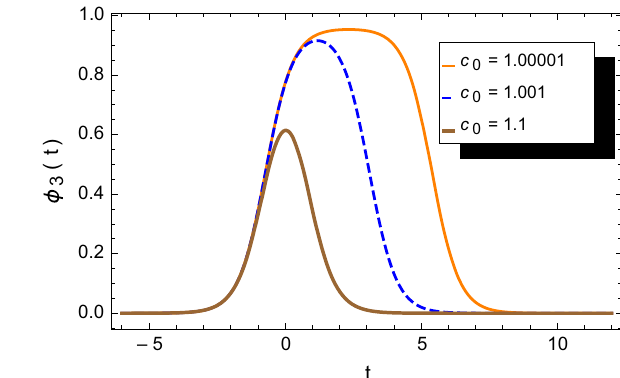
Fig. 1 Profiles of the DBW solutions φ ( 1 )